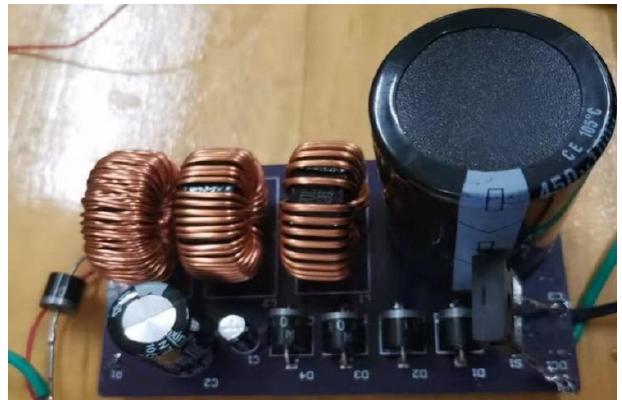
Figure 12. Hardware prototype of three-order boost converter.